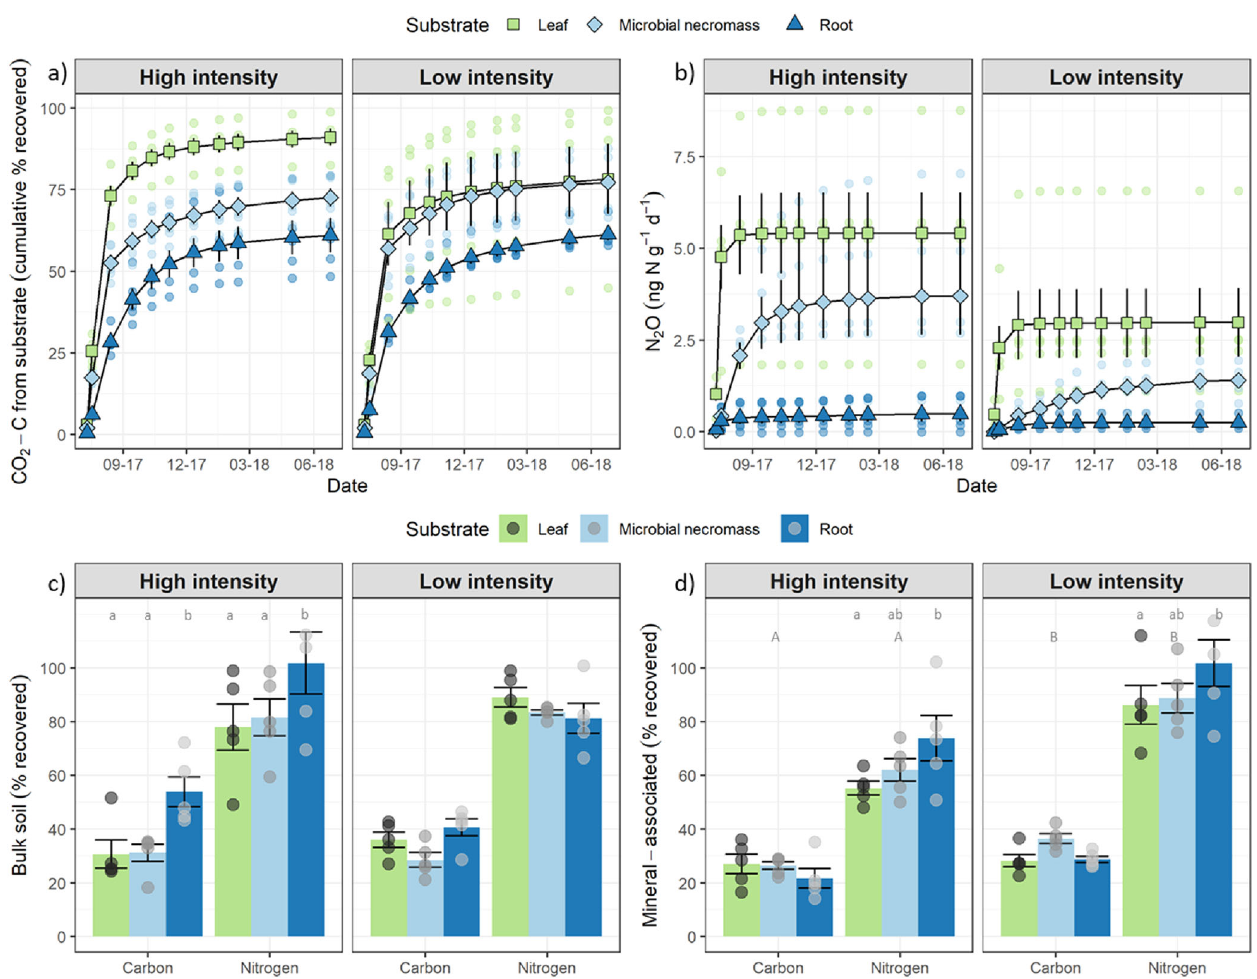
Fig. 2 Microbial substrate preference does not in fl uence substrate C stabilization. The cumulative mean (and standard error, n = 5) % recovered